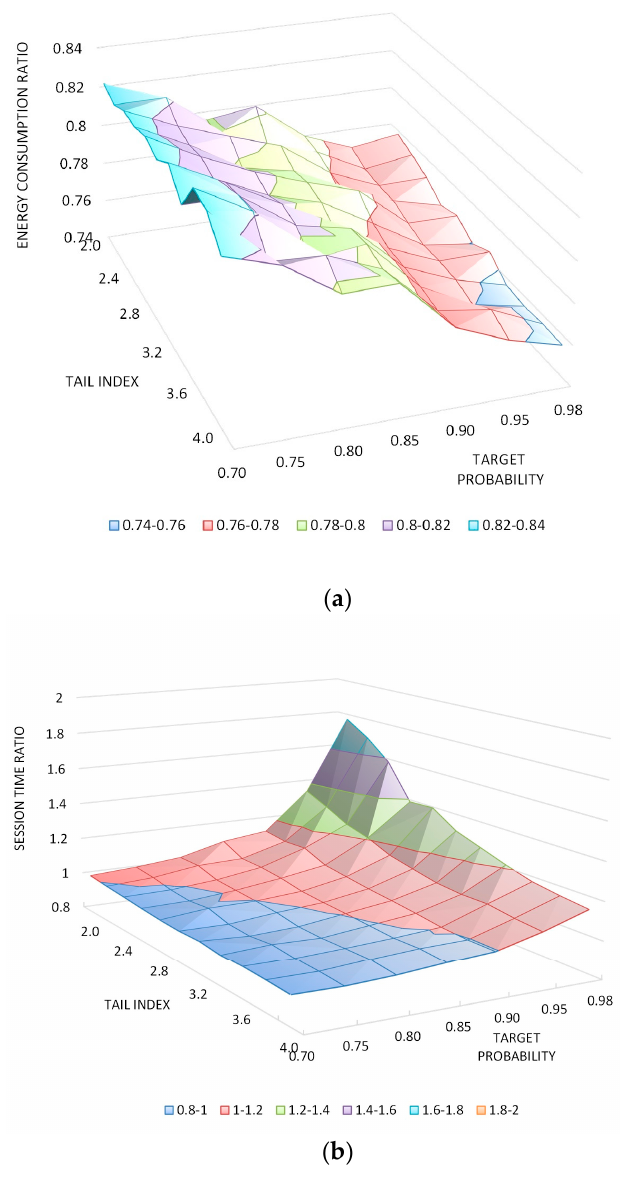
Figure 16. Ratio of PBESM to legacy NB-IoT according to tail index and target probability: ( a ) energy consumption; ( b ) active time.